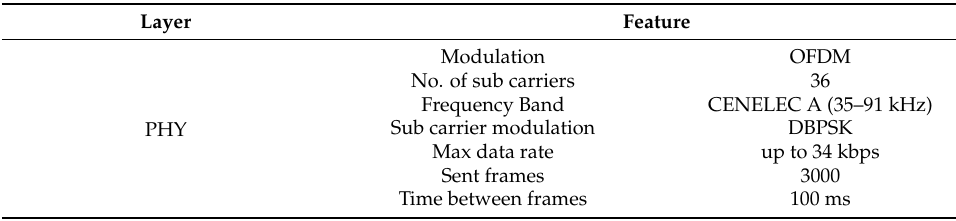
Table 2. Specifications of the G3-PLC considered in this work.